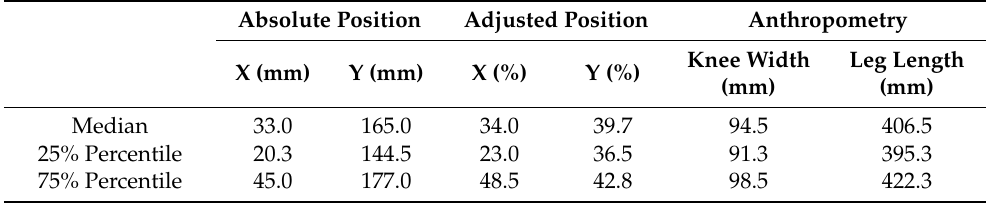
Table 1. Absolute and Adjusted position of innervation zones of the medial gastrocnemius muscle (n = 24). Data are presented as medians and interquartile ranges. Absolute Position Adjusted Position